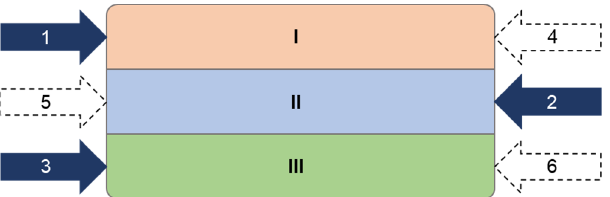
Figure 16. Schematic top view of the substrate deployed for catalyst immobilization, divided into three parts (I, II, III). Where the spray cone ejected by the spray gun was centered for each stride, arrows indicate the starting points of the strides (1–6); the whole coating process required more than the six indicated strides.